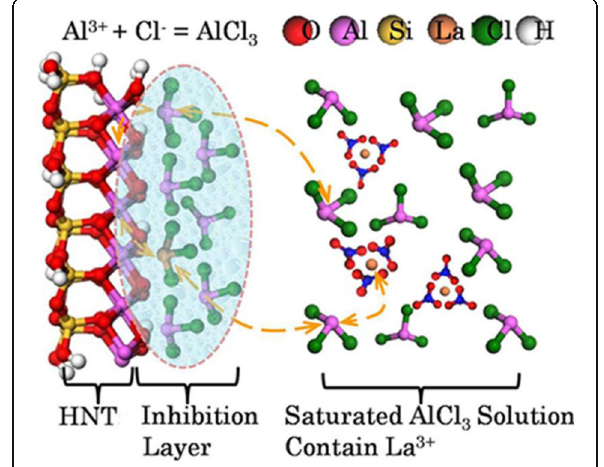
Fig. 6 Proposed mechanism of La doping into